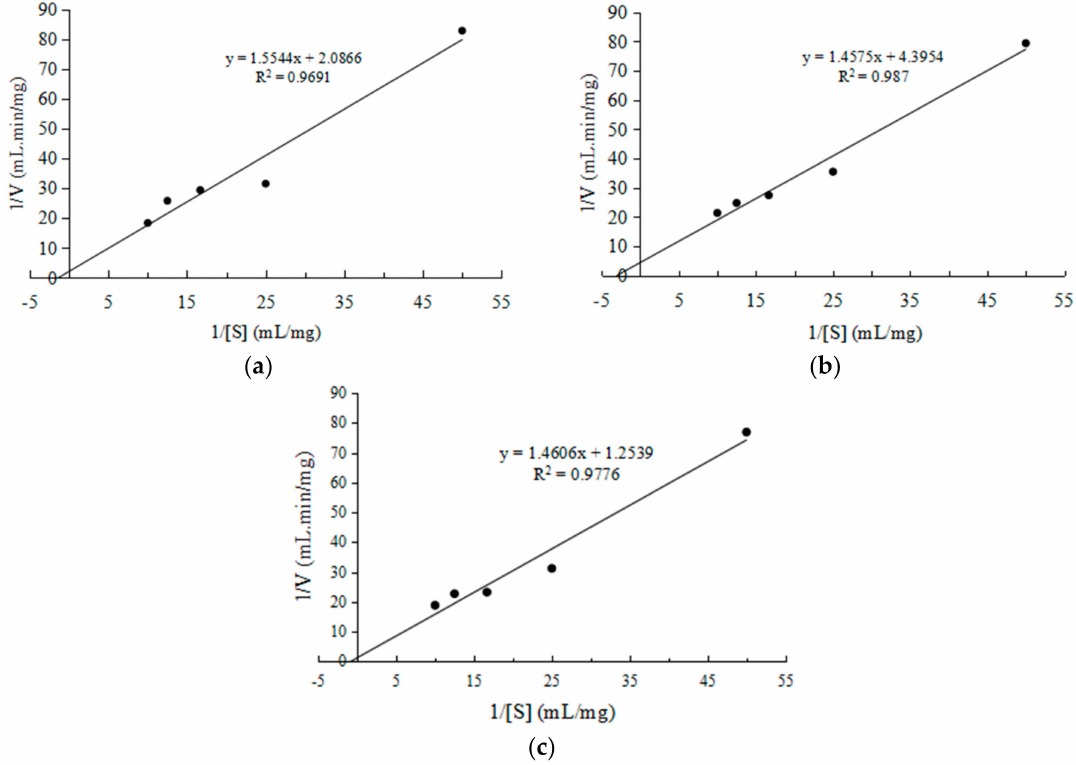
Figure 6. Determination of Lineweaver–Burk graph for CEP from L. plantarum LP69 at five different concentrations of various substrates ( a ) whey protein, ( b ) lactoglobulin and ( c )